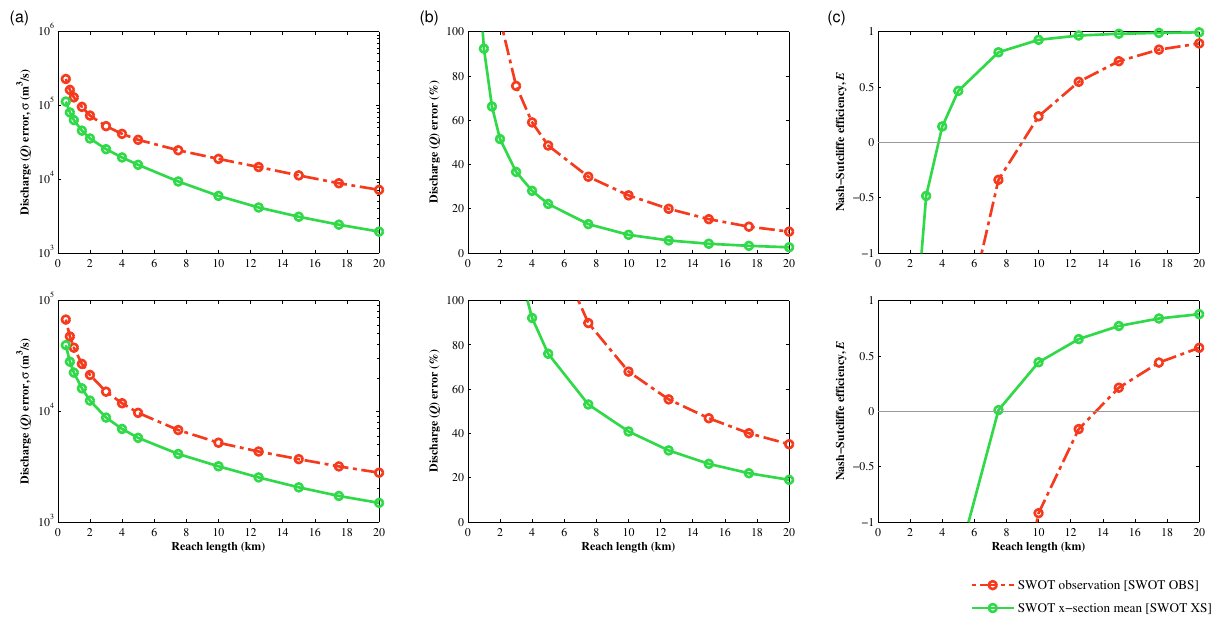
Figure 13. Errors in discharge ( Q ) as related to reach-length averaging, calculated against slope and discharge obtained using water elevation “truth” images ( Q [ TRUE ] ): (a) absolute discharge error; (b) error expressed as a percentage of mean discharge; and (c) Nash–Sutcliffe efficiency coefficient. The horizontal line in (c) represents the level of “acceptable” error in modelled discharge estimates. Top row: Solimões; bottom row: